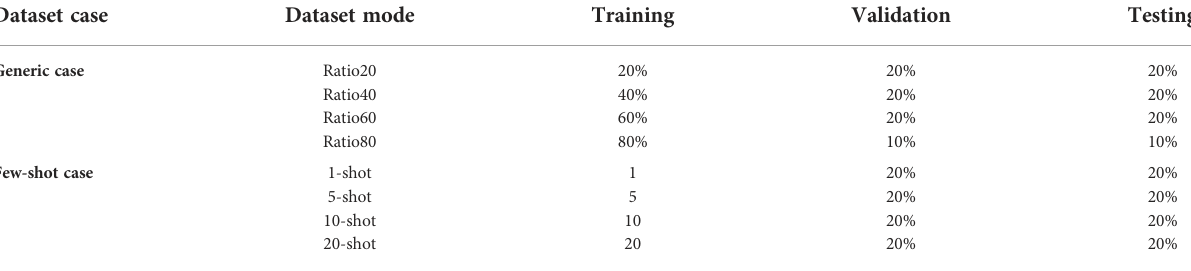
TABLE 2 The settings in different dataset modes for the original dataset without labeled testing dataset.